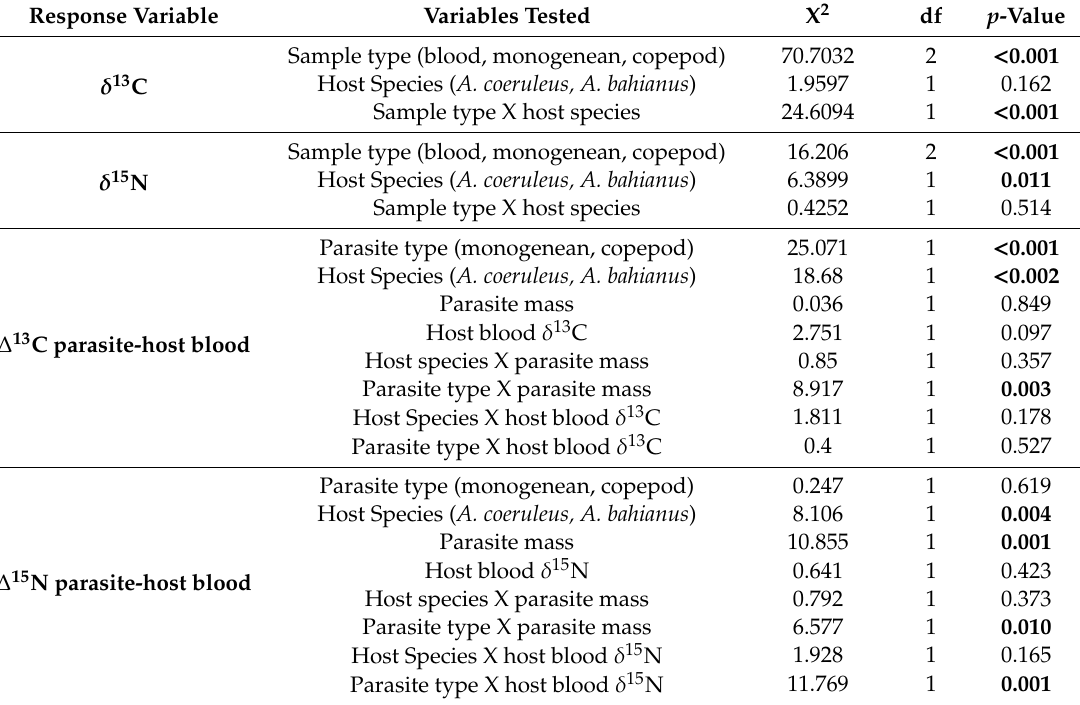
Table 1. Results from type-II (hierarchical) analysis-of variance (Wald X 2 ) on full models which included all factors of interest. Factors which were deemed significant ( p -values in bold) were fitted to the final